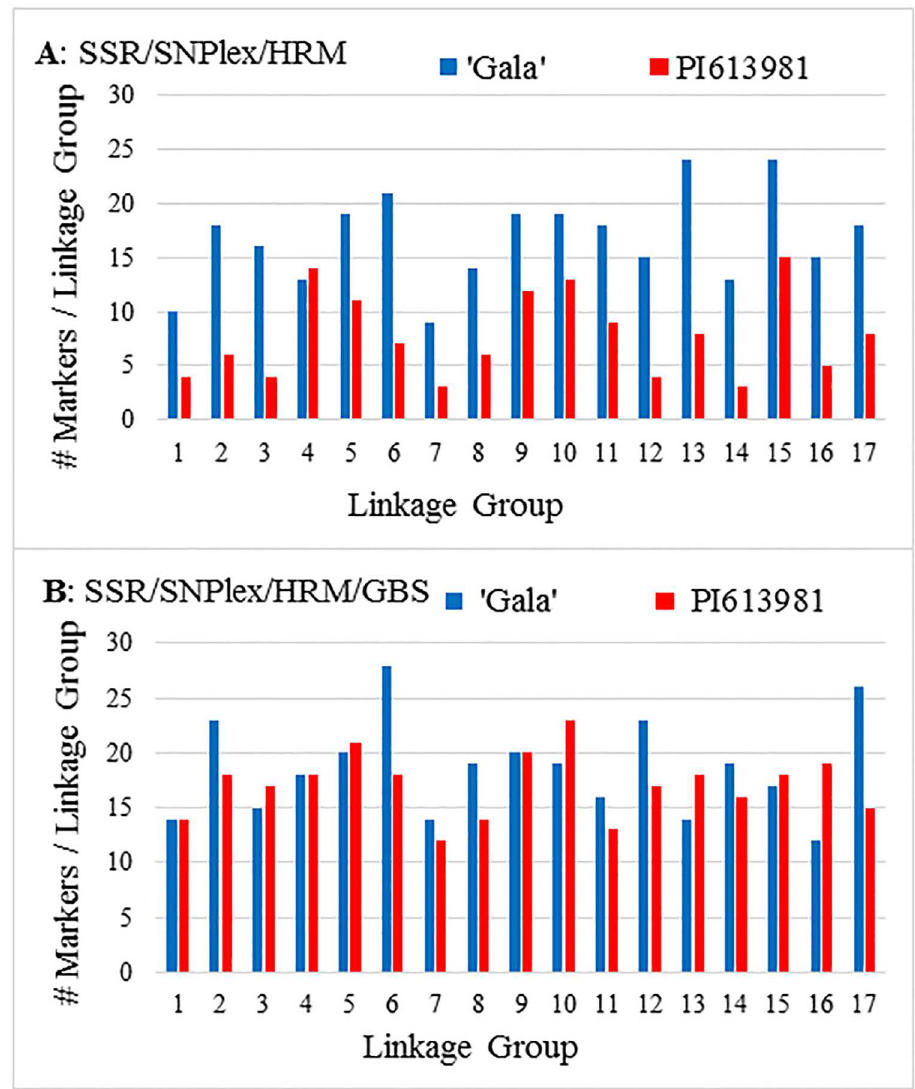
HRM markersand B) SSR, SNPlex, HRM, and GBS